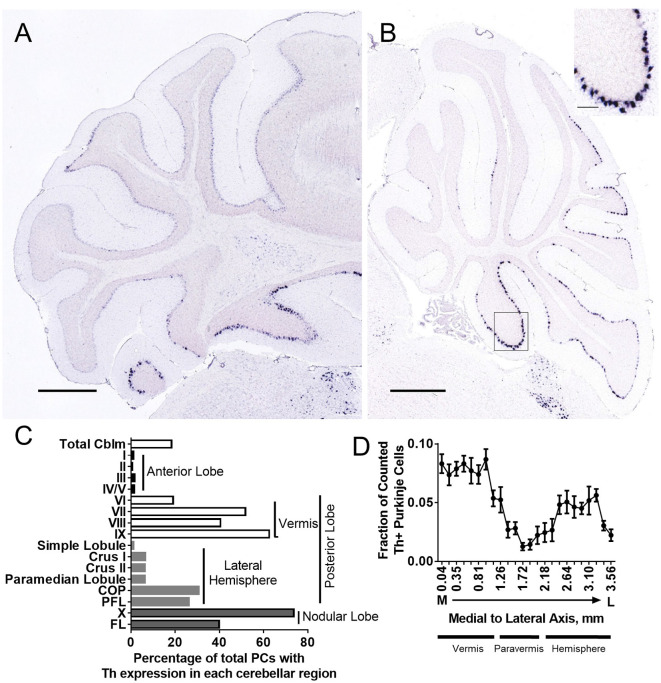
Th+ Purkinje cell counting with in situ hybridization (ISH). Th+ Purkinje cells (dark blue) populate multiple regions of the cerebellum. Th mRNA was measured in six brains from the Allen Brain Atlas (Table 1). (A) Coronal section from Allen Mouse Brain Atlas (2004). Image credit: Allen Institute (Experiment 1056; Lein et al., 2007). (B) Sagittal section from Allen Mouse Brain Atlas (2004). Image credit: Allen Institute (Experiment 1058; Lein et al., 2007). Scale bar = 652 microns. N = 6 brains. Inset, higher magnification from area in square. Inset scale bar = 100 microns. (C) Estimated percentage of Purkinje cells with Th+ expression in each cerebellar cortical region. (D) A fraction of counted Th+ Purkinje cells in sagittal sections along medial to the lateral axis. Error bars are SEM.